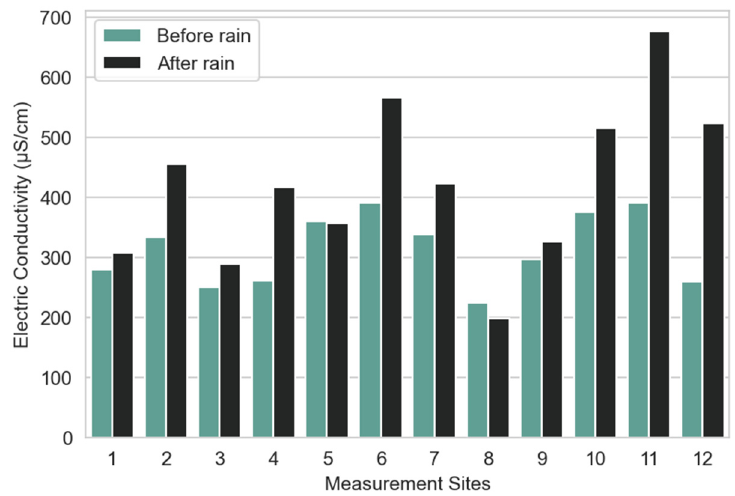
Figure 12. Average soil conductivity per measurement site before and after rain.